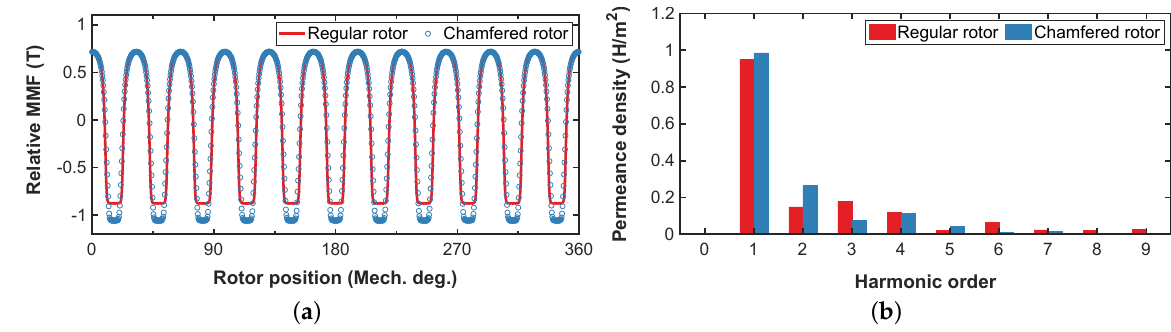
Figure 5. Rotor relative MMF in both structures with infinite permeability. ( a ) Permeance plot; ( b ) Permeance spectrum.